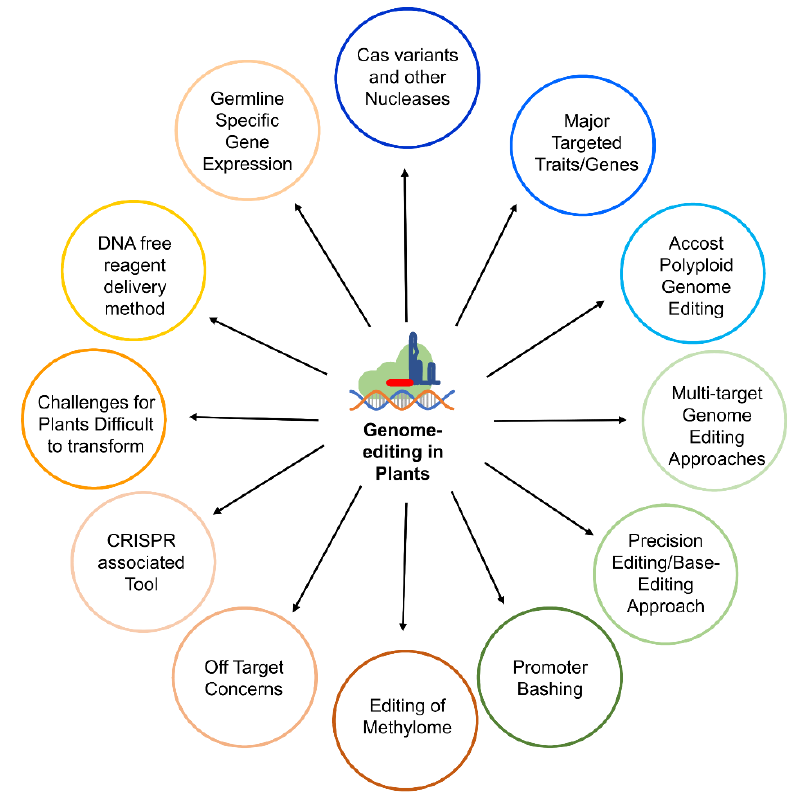
Figure 1. An overview of the different aspects covered in the present review related to the CRISPR/Cas (clustered regularly interspaced short palindromic repeats/CRISPR-associated protein) based genome editing in plants.